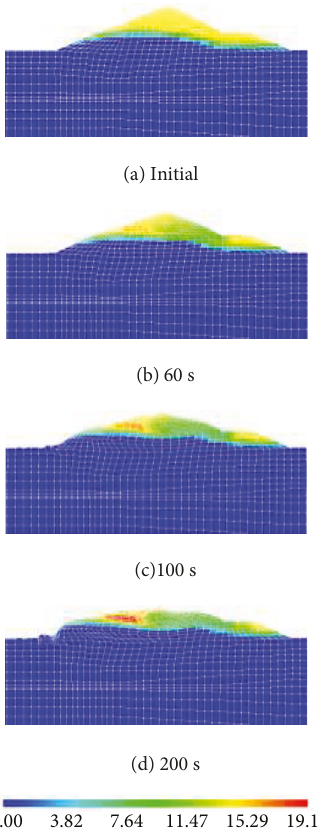
Figure 28: Distribution of degree of